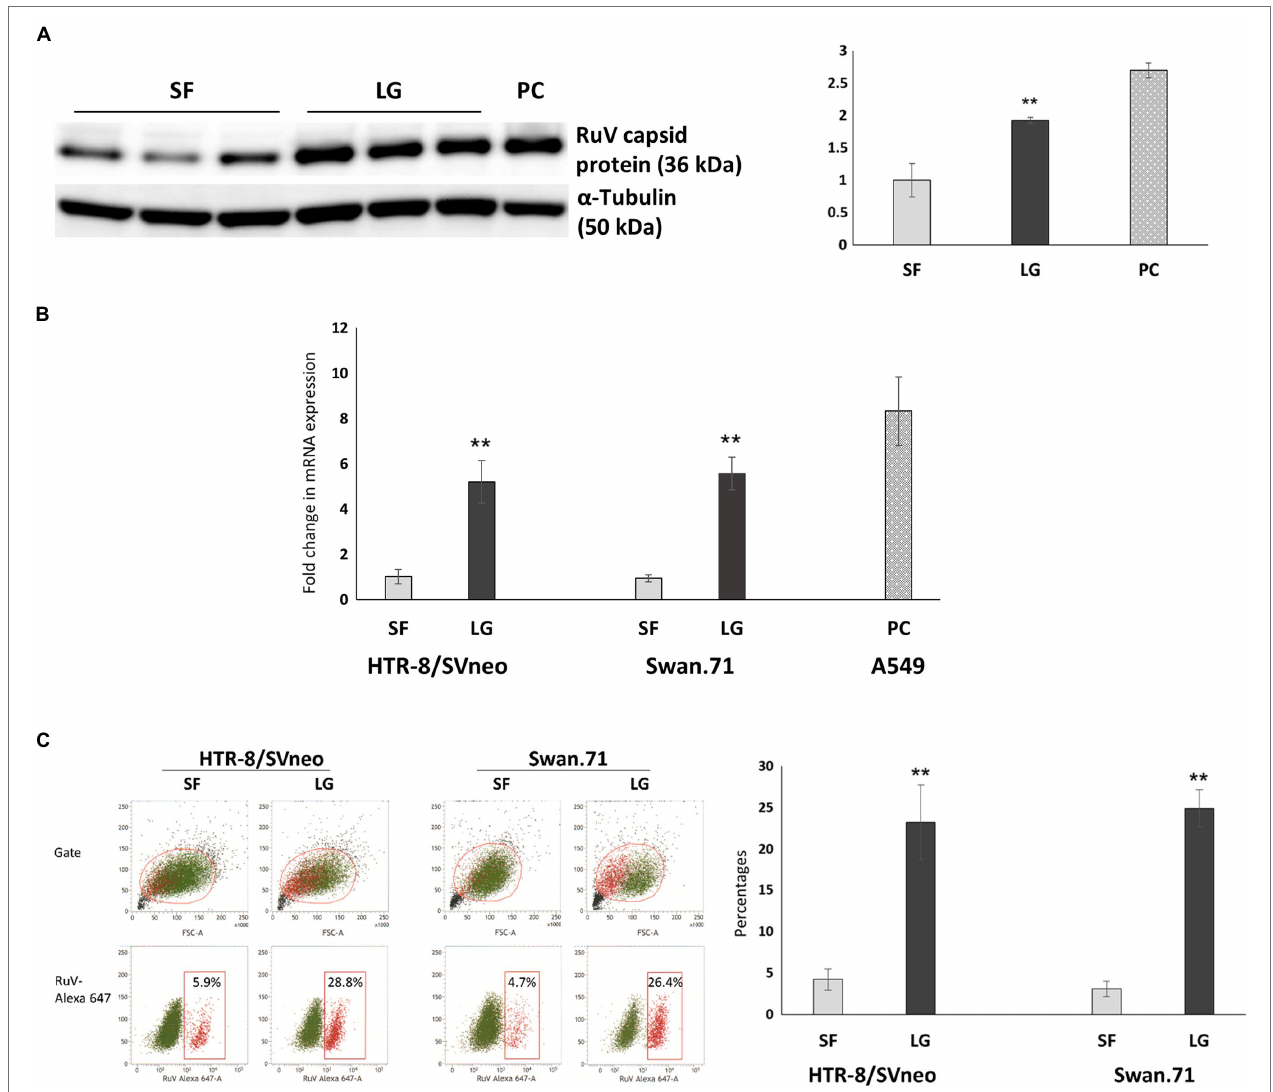
FIGURE 5 | Viral binding assays showed an enhancement of RuV binding to LG-stressed trophoblast cells. After LG stress treatment, the cells were inoculated with RuV at an MOI of 5 to 10 on ice for 1 h. After washing, the cells were lysed and subjected to Western blot analysis, RNA extraction, and real-time PCR, or surface staining procedures for RuV were performed, and the cells were analyzed by FCM. (A) Increased expression of the RuV capsid protein in HTR-8/SVneo cells under LG stress, as shown by Western blot analysis. The graph was constructed based on band intensities (arbitrary units) normalized to the value of the cells cultured in SF medium. Values shown are the mean of three independent experiments ± SEM. PC, A549 cells. (B) Increased viral RNA expression in HTR-8/SVneo and Swan.71 cells cultured in LG medium. Data shown are the means of fold-change of relative expression values (normalized to the internal control PPIA gene expression) ± SEM. (C) Increased percentages of RuV-positive HTR-8/SVneo and Swan.71 cells cultured in LG medium determined by FCM analysis. (B,C) The results are expressed as the mean (± SEM) of at least triplicate experiments in each group, and the graph is representative of two independent experiments. ** p <